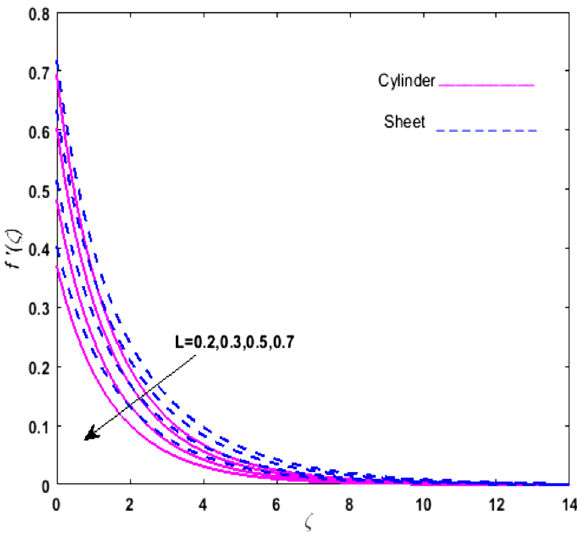
Figure 4. Upshot of L on f ′ (ζ) .